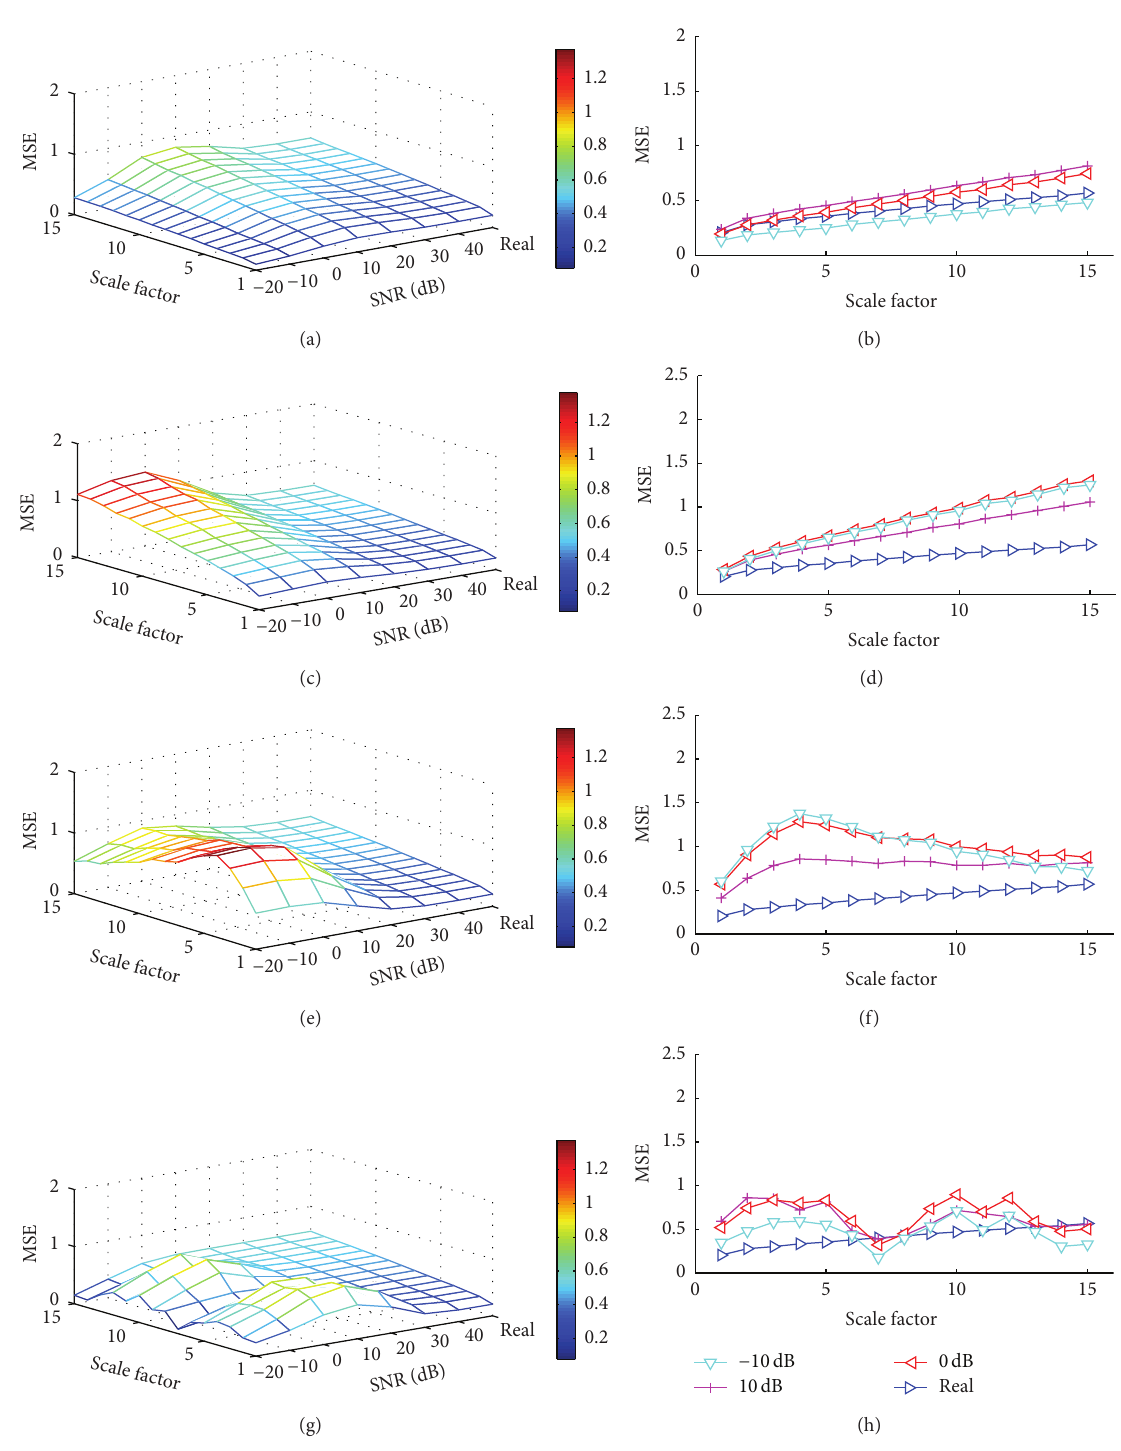
Figure 6: The validation results of SNR effect on MSE for the real ECG signals. (a), (c), (e), and (g) are the 3D view of the MSE of the real ECG plus BW, EM, MA, and PL, with SNR from − 20 dB to 40 dB with a step of 10dB, respectively. (b), (d), (f), and (h) are the MSE values of the noisy ECGs with − 10dB, 0dB, 10dB, and the real ECG,